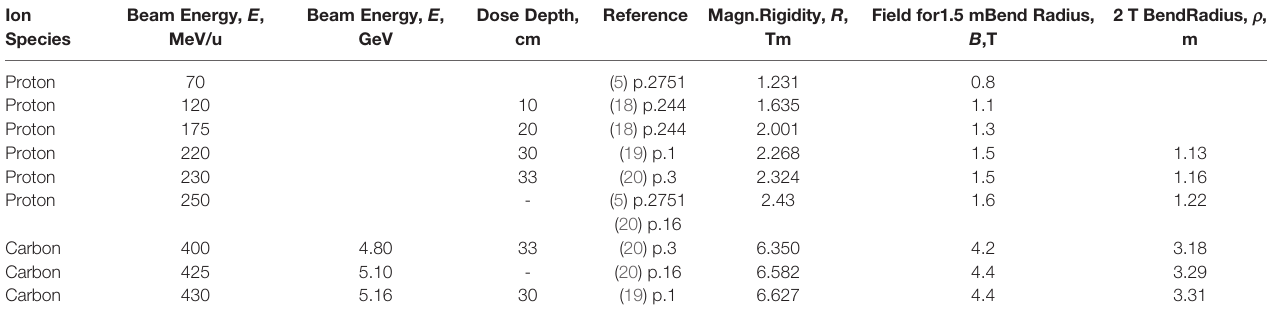
TABLE 6 | Ion energies and dose penetration depths, also calculated magnetic rigidities, fi elds for 1.5-m-Bend radius, and 2-T-Dipole bend radii. Ion Beam Energy, E , Beam Energy, E , Dose Depth, Species MeV/u GeV